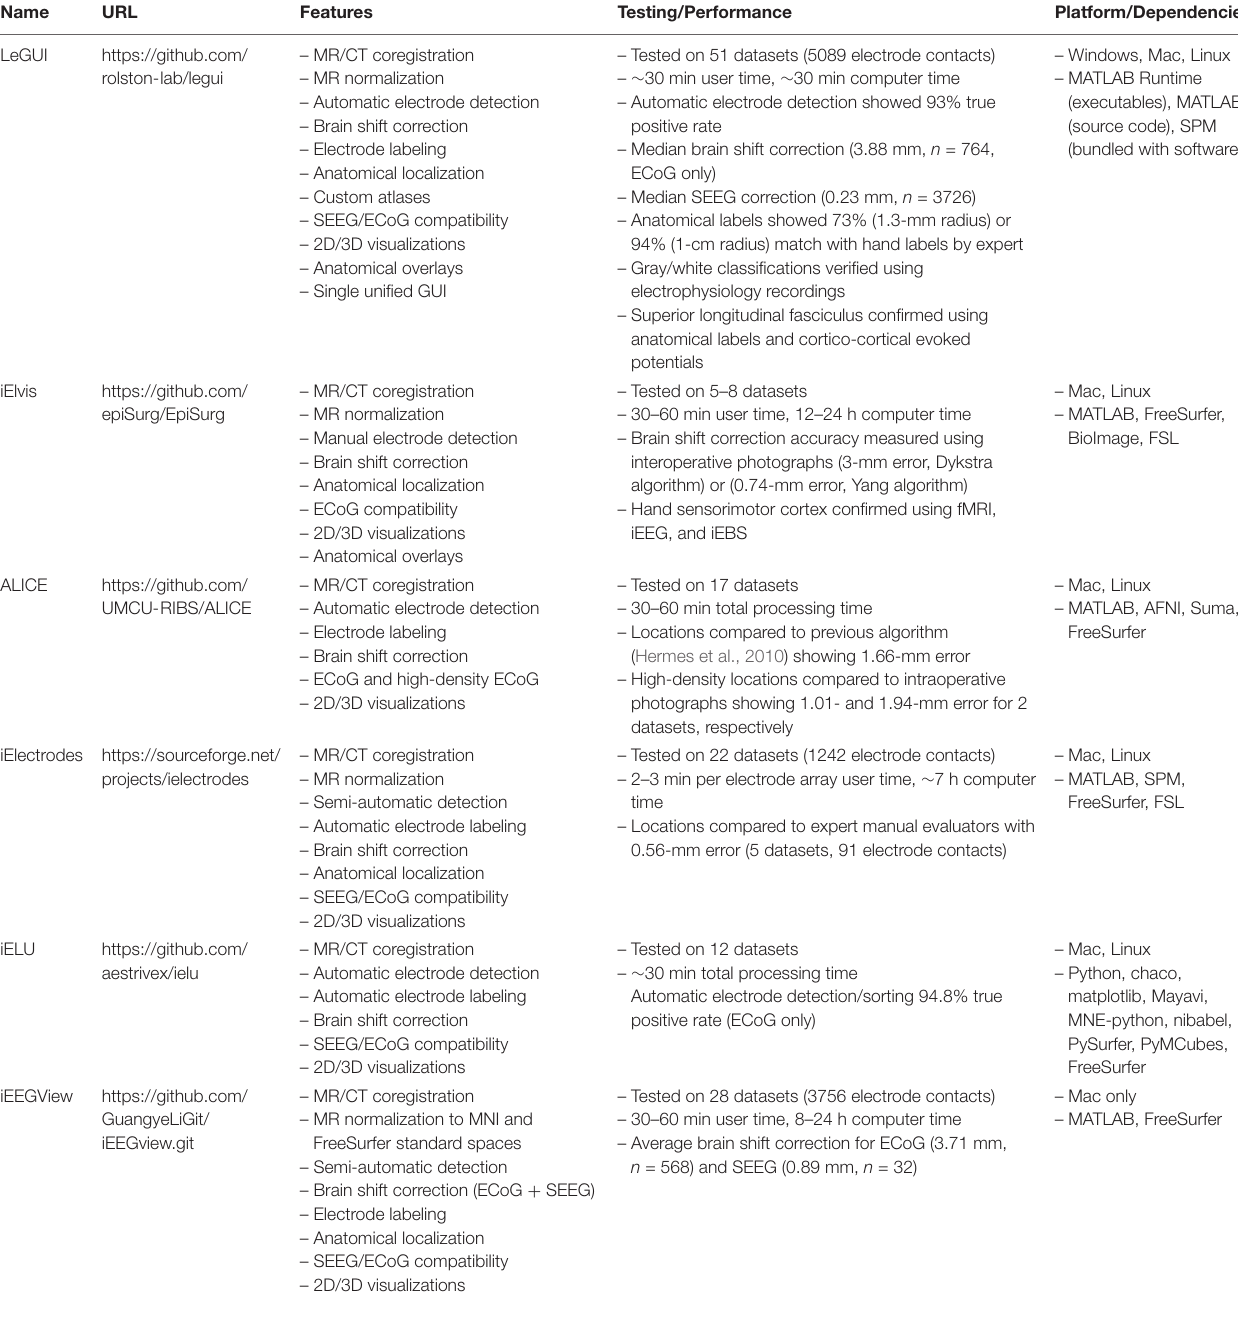
TABLE 1 | Comparison of intracranial electrode localization